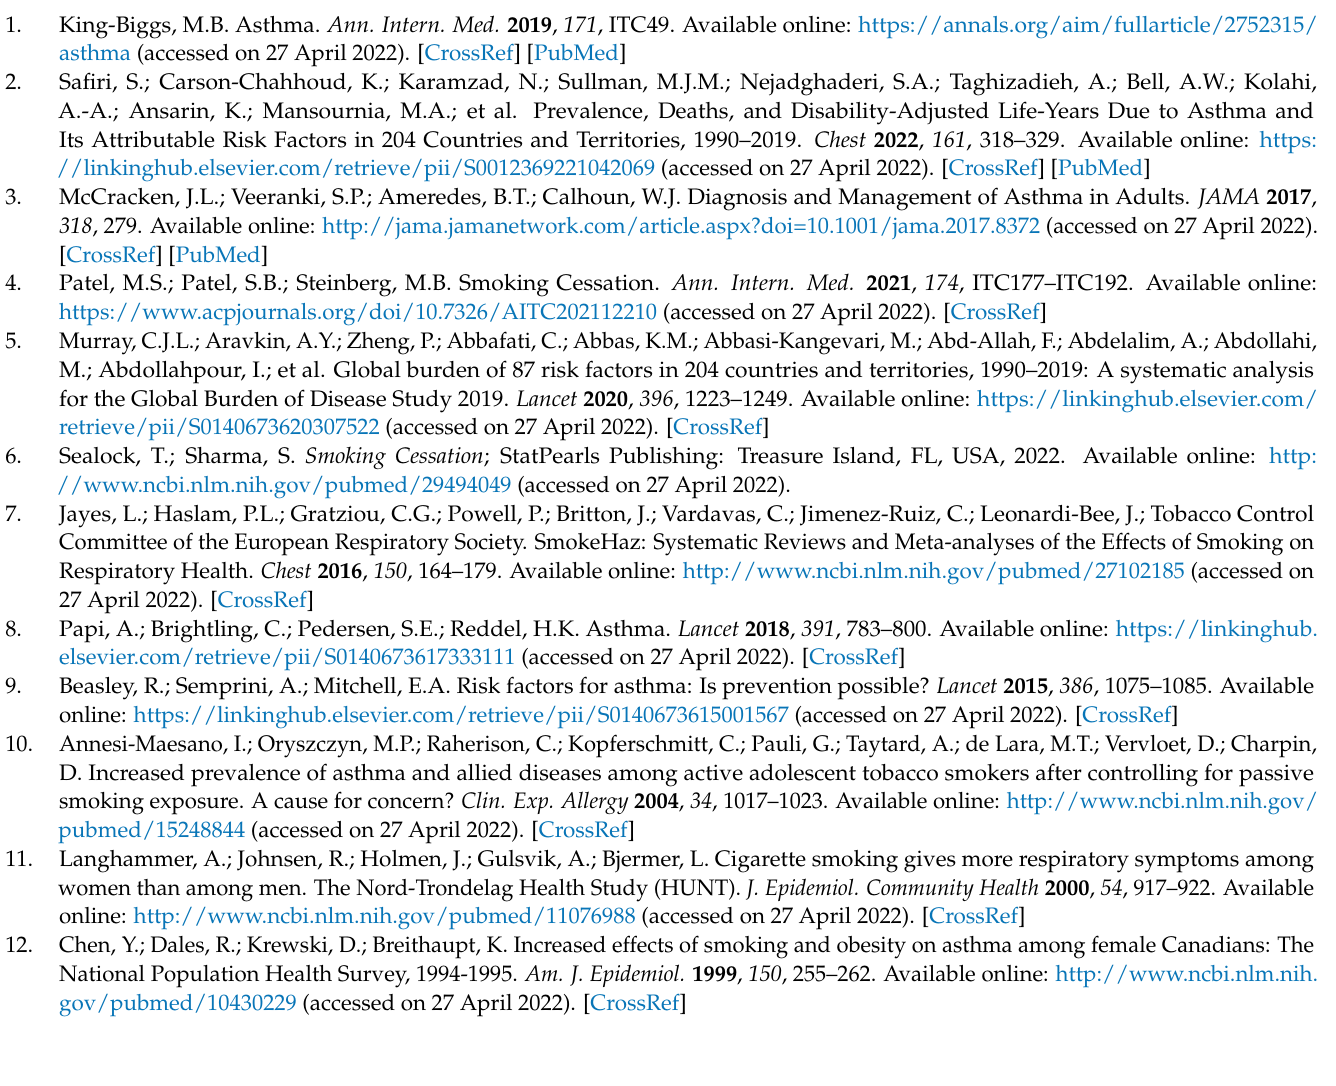
Table 2. Summary of myths and realities of association of asthma and smoking. Myth Reality There is no established causal association between Smoking causes asthma tobacco exposure and asthma, and existing evidence is conflicting Smoking may cause fixed airway obstruction, but other Smoking hinders asthma diagnosis disease characteristics enable accurate diagnosis Smoking is associated with worse clinical outcomes and Smoking impairs asthma prognosis disease control in asthma patients The main anti-asthmatic medications remain effective in Smoking interferes in asthmatic smokers. asthma treatment However, there is some evidence for reduced efficacy of inhaled